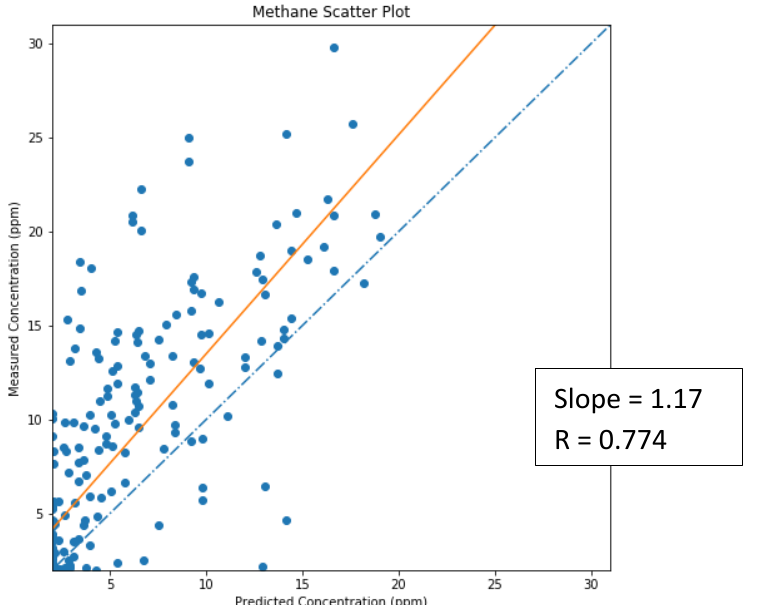
Figure 17. Scatter plot of measured methane concentrations versus modeled concentrations for 28 September 2021, 9:01 a.m. to 9:54 a.m. R denotes the correlation coefficient. The (orange) regression and (blue) 1:1 lines are also displayed.